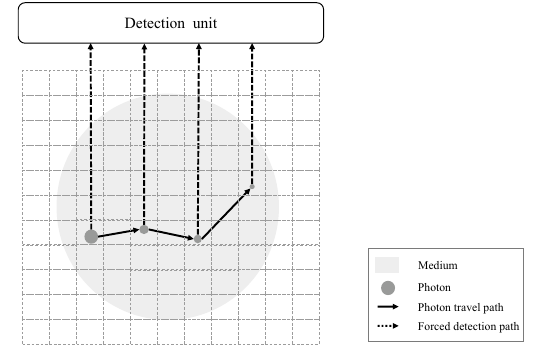
Figure 14. Illustration of the CFD technique. A photon shown as the gray disk is created on the left and travels in the medium along the solid arrow. The disk radius represents the photon energy. Upon it creation and each interaction with the medium, the photon is forced to be scattered along the dash arrow and to be detected by the detector with a certain